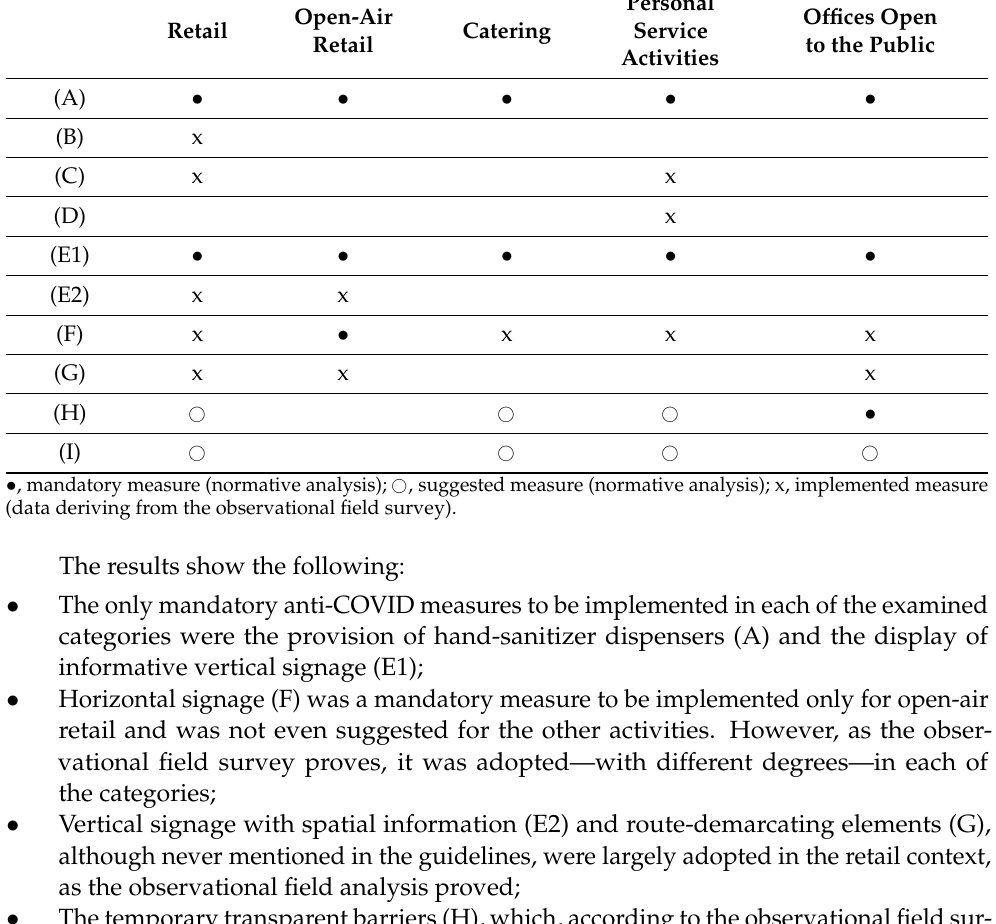
Table 9. Synthesis of the compulsory and/or suggested anti-COVID measures for the five categories of facilities investigated (retail, open-air retail, catering, personal service activities, offices open to the public), also including the integrative measures identified during the field survey (mandatory measures were always implemented). Own processing. Personal Open-Air Offices Open Retail Catering Service Retail to the Activities